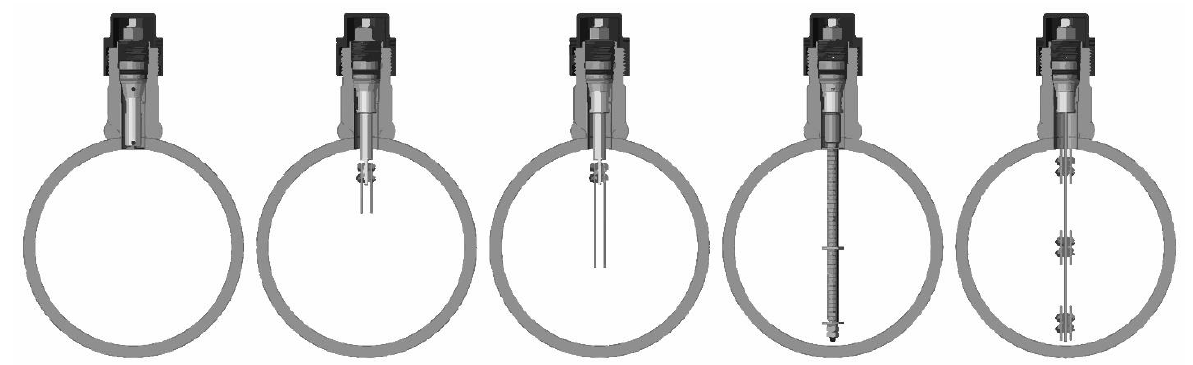
Figure 2. The different types of corrosion coupons installed inside the structure.